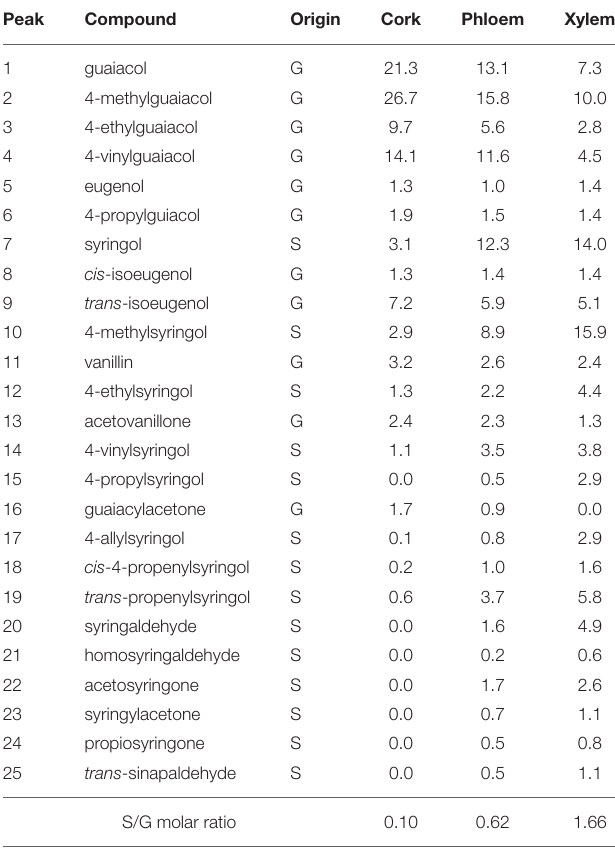
TABLE 2 | Identities and relative molar abundances (% of identified products) of the lignin-derived compounds from pyrolysis of milled lignins of cork, phloem and xylem of Quercus suber L. Peak assignment from Figure